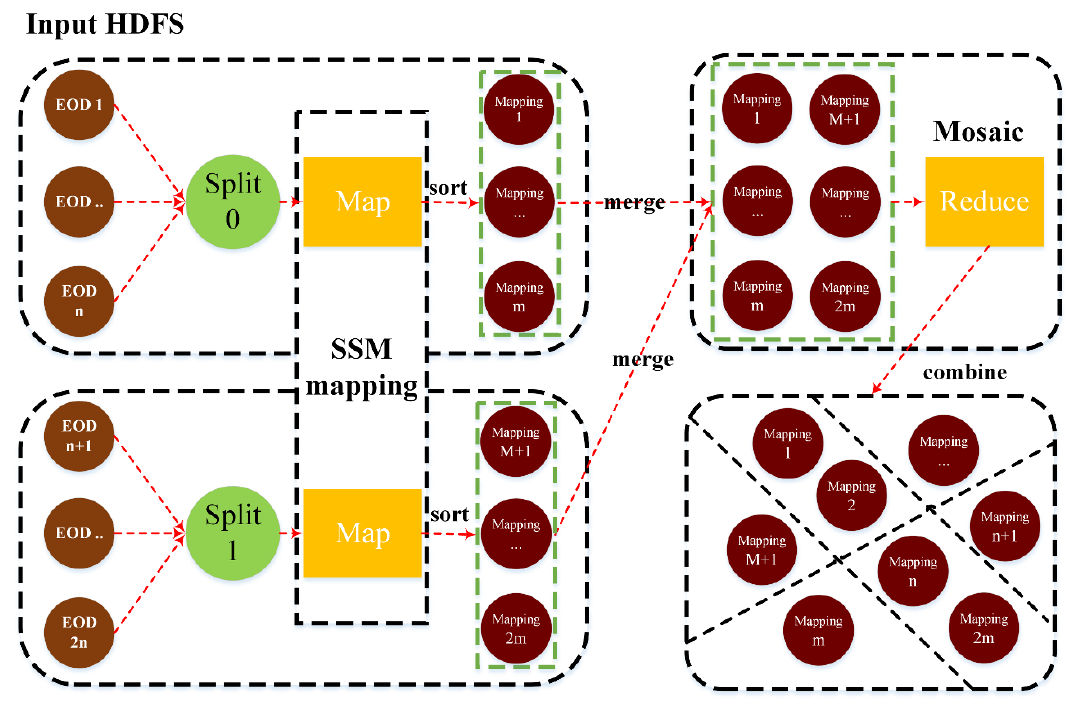
Figure 2. Map/reduce workflow for EOD in the proposed Framework. EODx represents the specific remote sensing image, such as a GF-1 image, and mappingx represents the SM mappingx inverted by the SM inversion index.